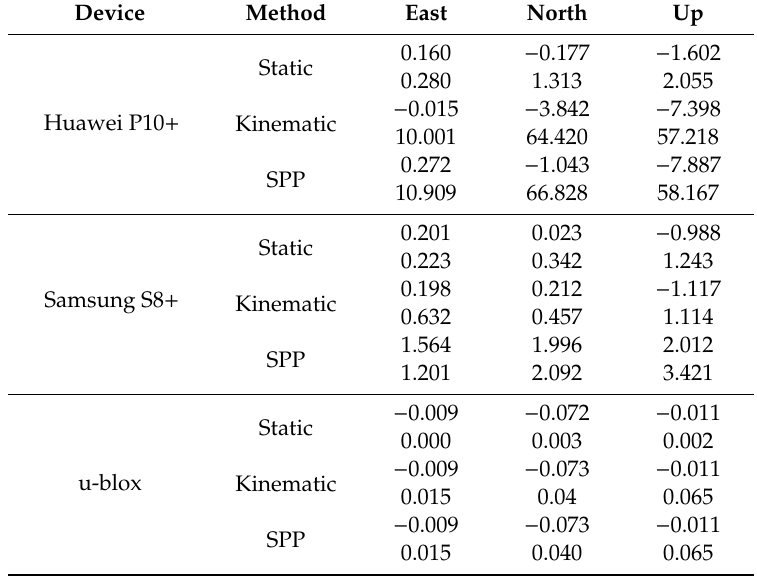
Table 8. Accuracy (upper line for each method) and precision (lower line for each method) results considering a session length of 1 h. All results exceeding a threshold of 3 m are highlighted inside the